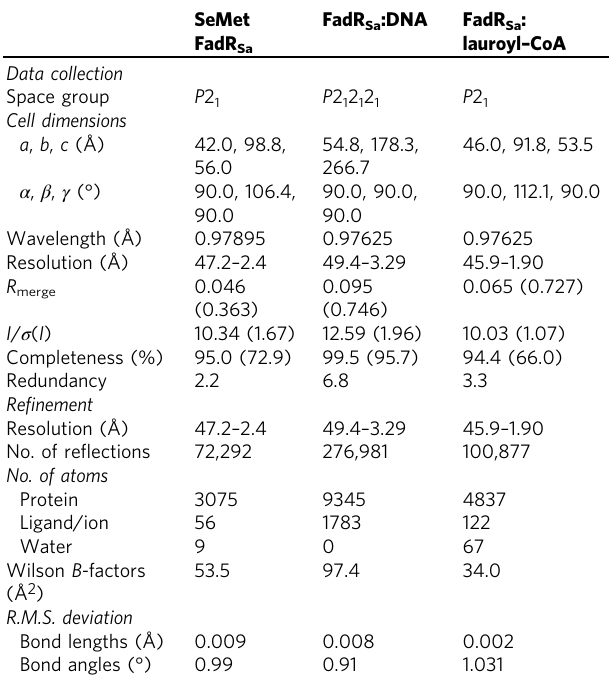
Table 1 Data collection and re fi nement statistics (values in parentheses are for outer resolution